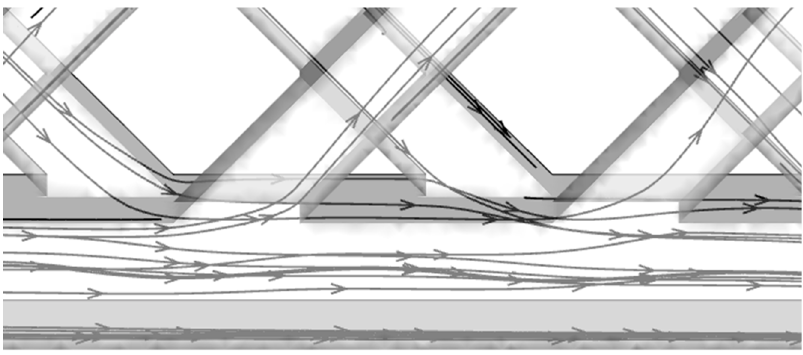
Figure 14. Streamlines at the intersections of subchannels and slot (Re=132).